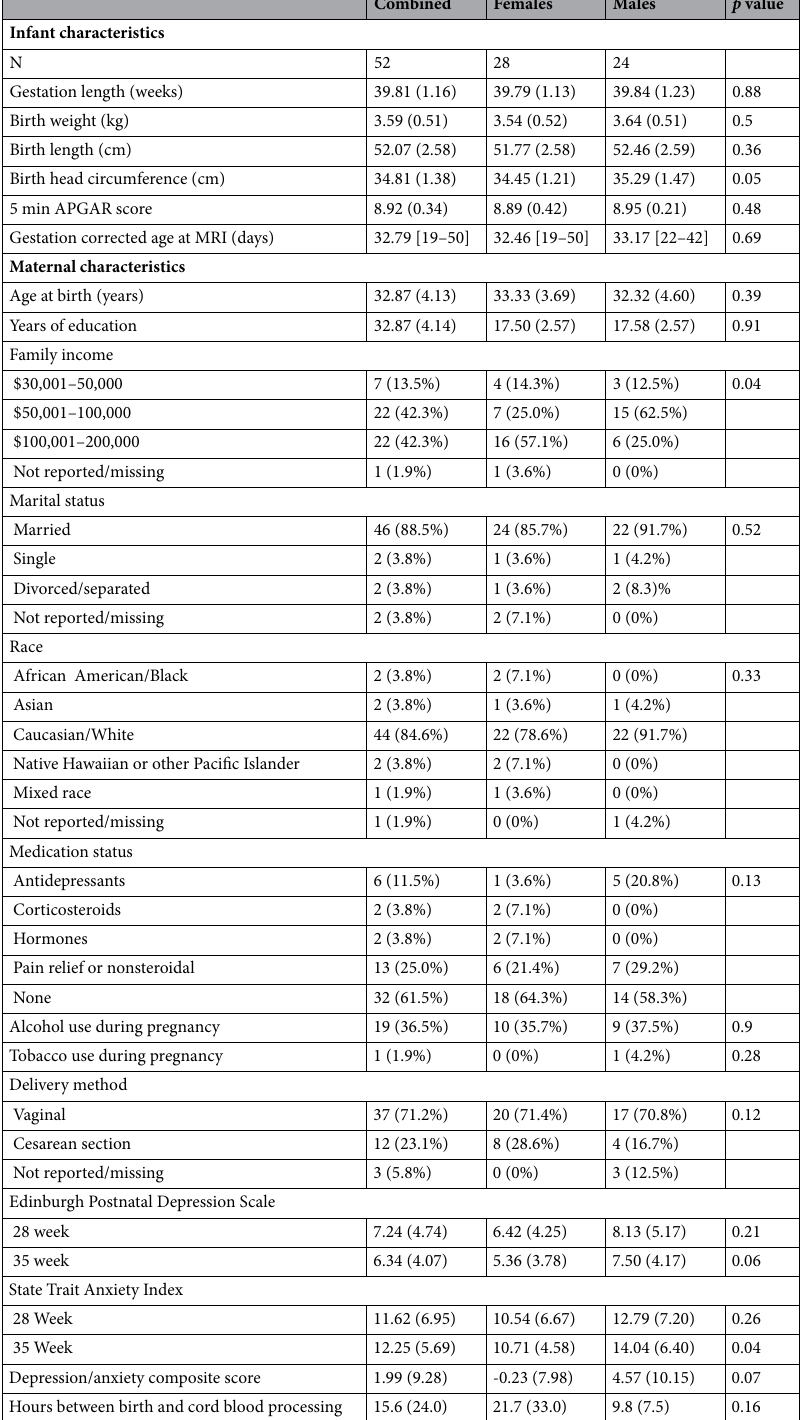
Table 1. Demographic information for study cohort. Data are presented as mean (standard deviation) or number (percentage), as indicated. P values correspond to comparisons between males and females using T-tests or Chi-squared tests, where